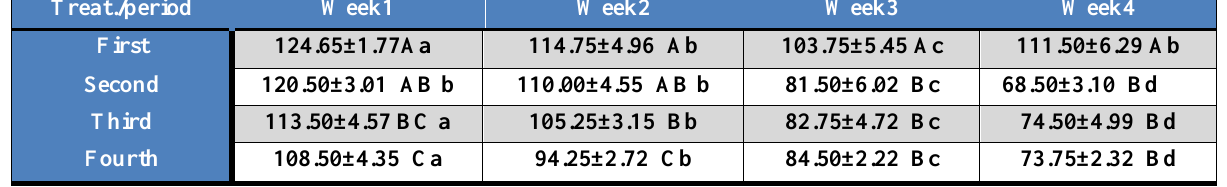
Table, 11: Effect of Vit. C and/or Vit.B on the Cholestrol concen. (mg/dl) of rabbits (Mean ± SE).